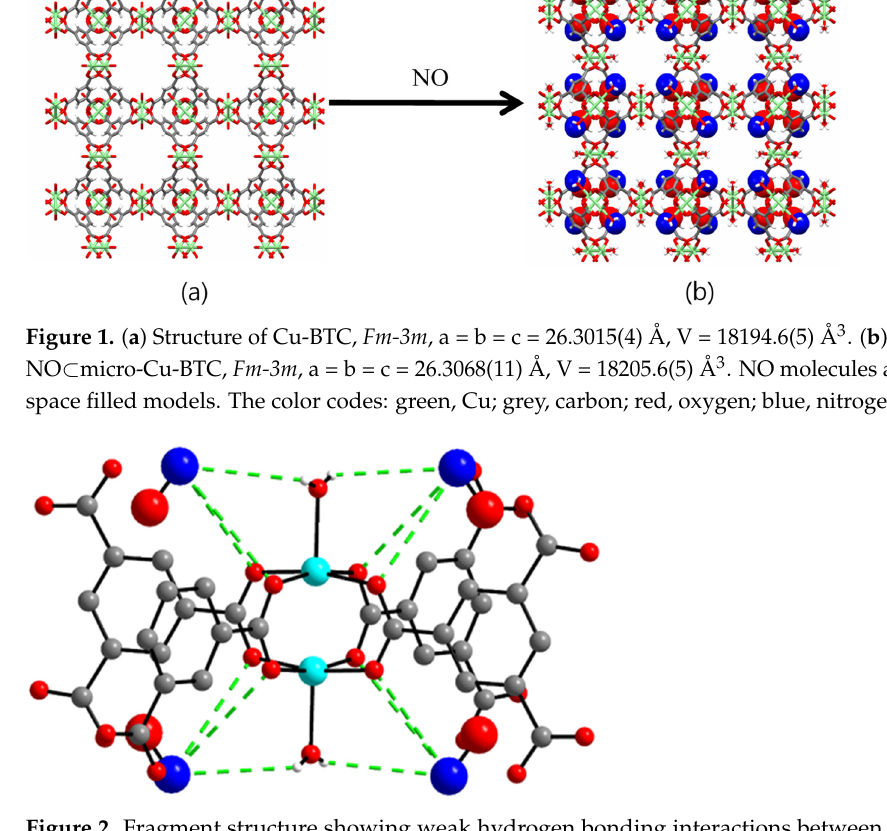
Figure 2. Fragment structure showing weak hydrogen bonding interactions between NO and the coordinated water molecules, and interactions between NO and carboxylate oxygen atoms. Color codes: green, Cu; grey, carbon; red, oxygen; blue, nitrogen. Hydrogen atoms, except those of water, were omitted. The large spheres represent NO for clarity.